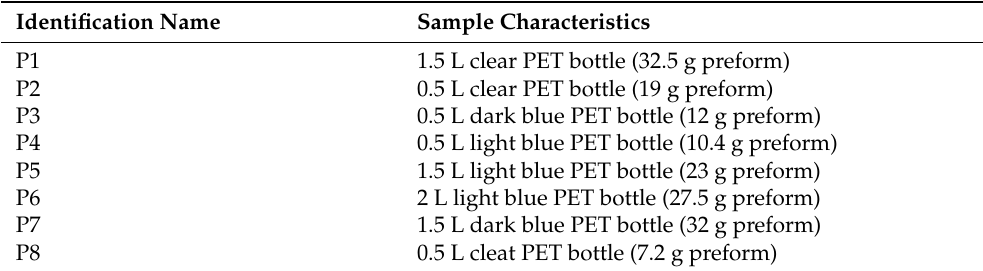
Table 3. Identification name and characteristic of PET bottles